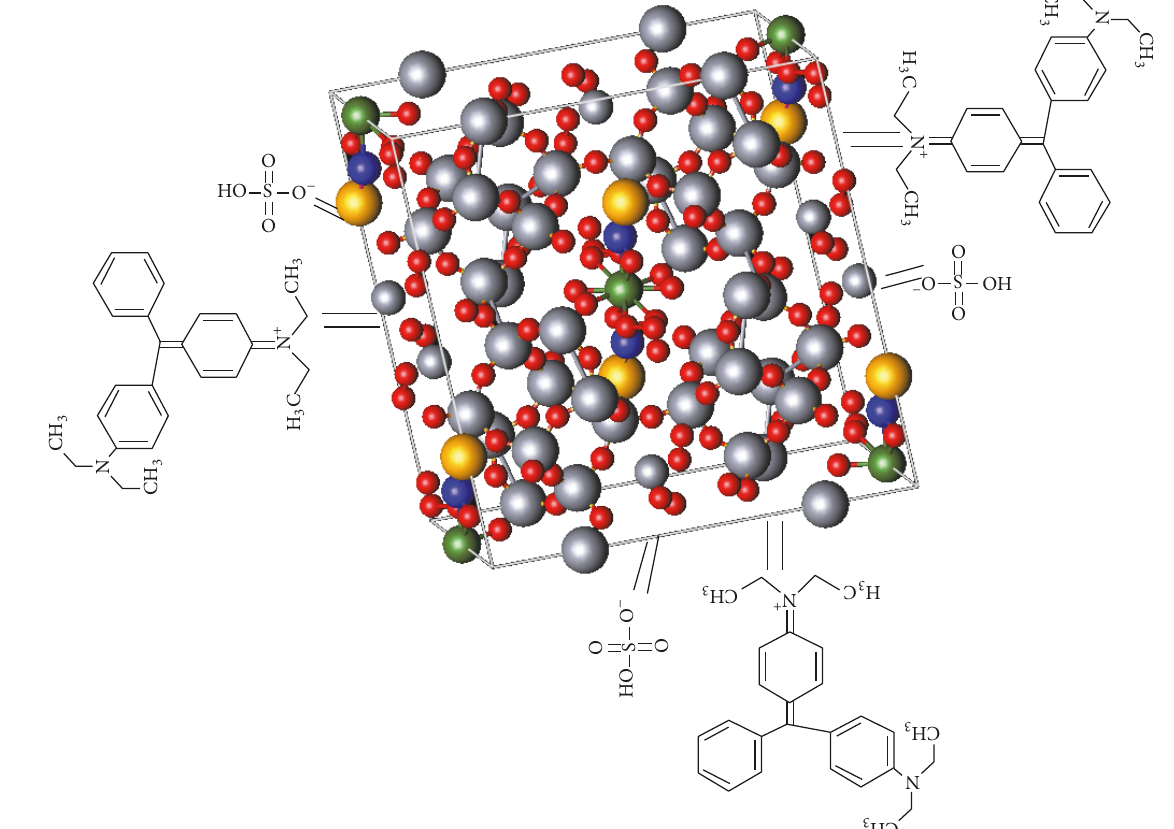
Figure 5: Schematic illustration of the adsorption process and interactions between the composite and